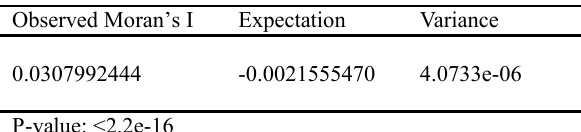
Table 3 . Moran’s I for regression residuals